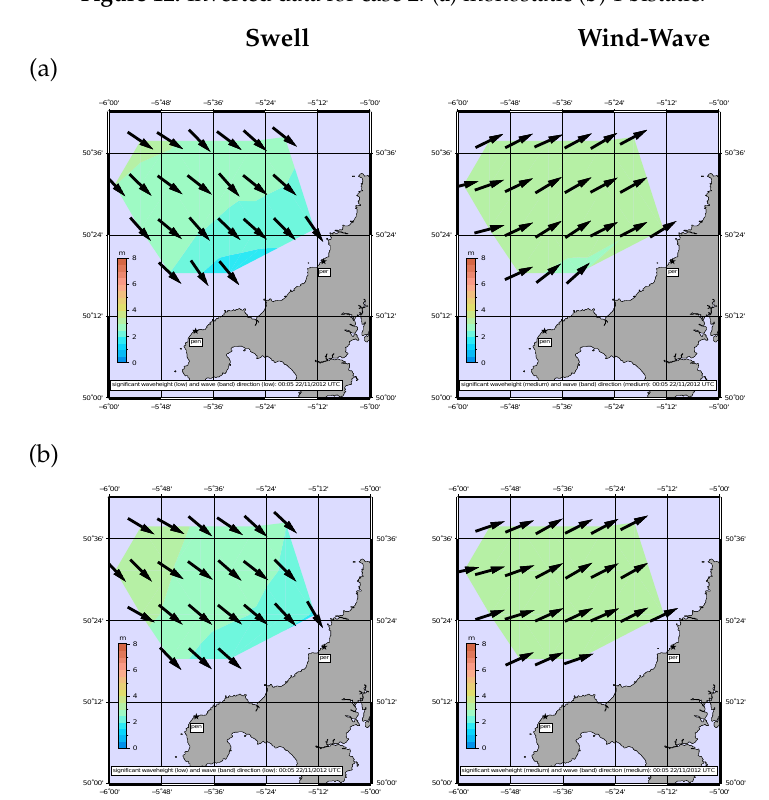
Figure 13. Inverted swell and wind wave components for case 2 ( a ) monostatic ( b ) 1